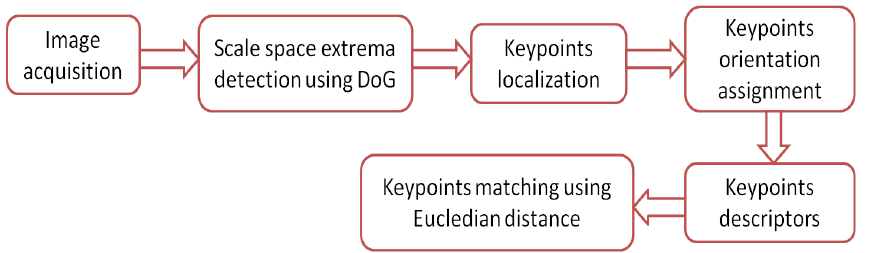
Figure 8. Flow chart for the SIFT algorithm.